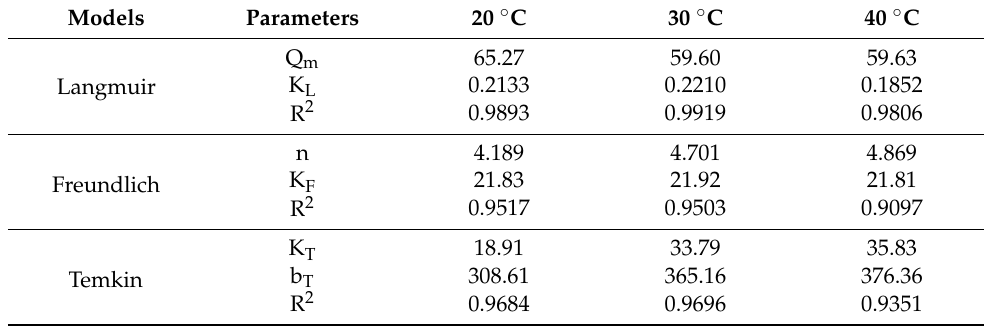
Table 4. Isotherm calculation parameters of MB absorbed on the LDHs@ANA composite.